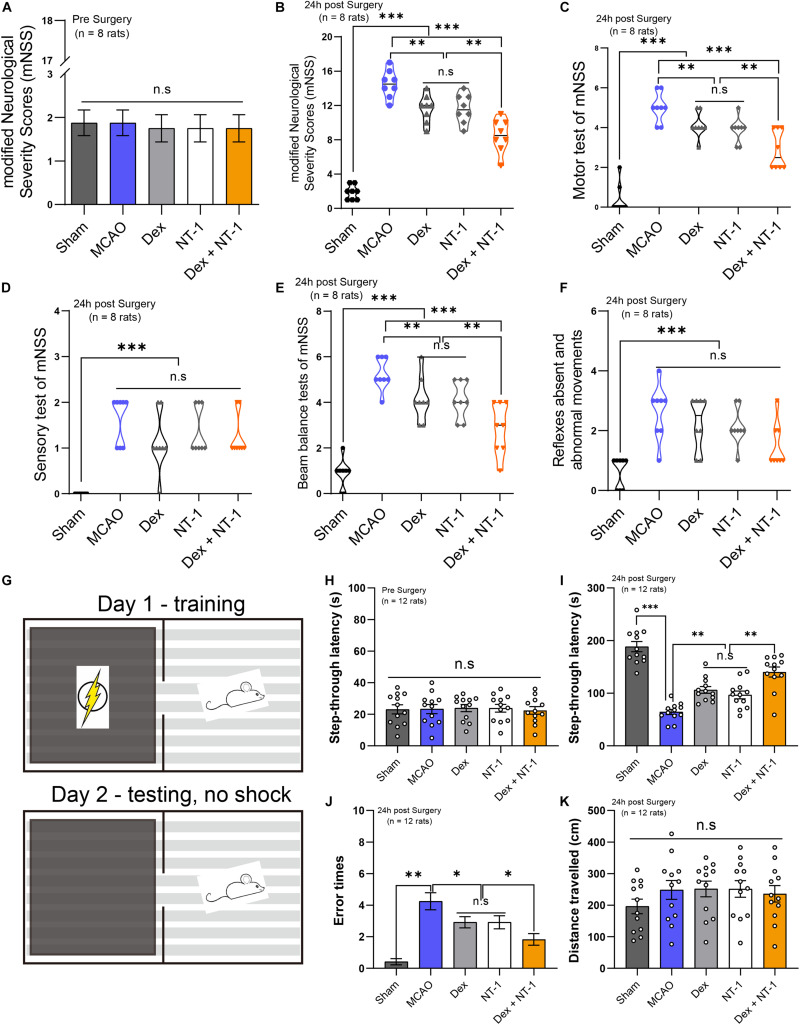
Combination of dexmedetomidine and Netrin-1 promoted the recovery of neurological function and alleviated the cognitive impairment after MCAO injury. (A) The basic values of modified Neurological Severity Scores (mNSS) of all experimental rats before MCAO model. (B) The mNSS of all experimental rats at 24 h after MCAO model. (C) The Motor test of mNSS. (D) The Sensory test of mNSS. (E) The Beam balance test of mNSS. (F) Reflexes absent and abnormal movements test of mNSS. Data are shown as the mean ± SD, n = 8. **P < 0.01 and ***P < 0.001 using one-way ANOVA followed by Tukey’s post hoc tests. (G) The schematic diagram of the step-through test. (H) The basic values of step-through latency of all experimental rats before MCAO model. (I) The latency to enter into the dark room of all experimental rats at 24 h after MCAO model. (J) The error times to enter into the dark room. (K) The total distance traveled. Data are shown as the mean ± SD, n = 12. ∗P < 0.05, ∗∗P < 0.01, ∗∗∗P < 0.001 using one-way ANOVA followed by Tukey’s post hoc tests.